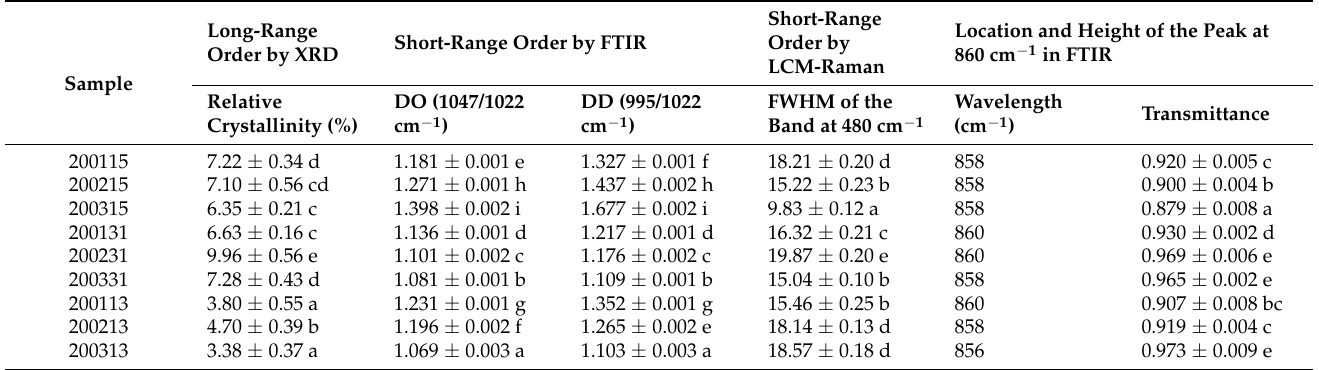
Table 5. The structural changes of starch in recombinant